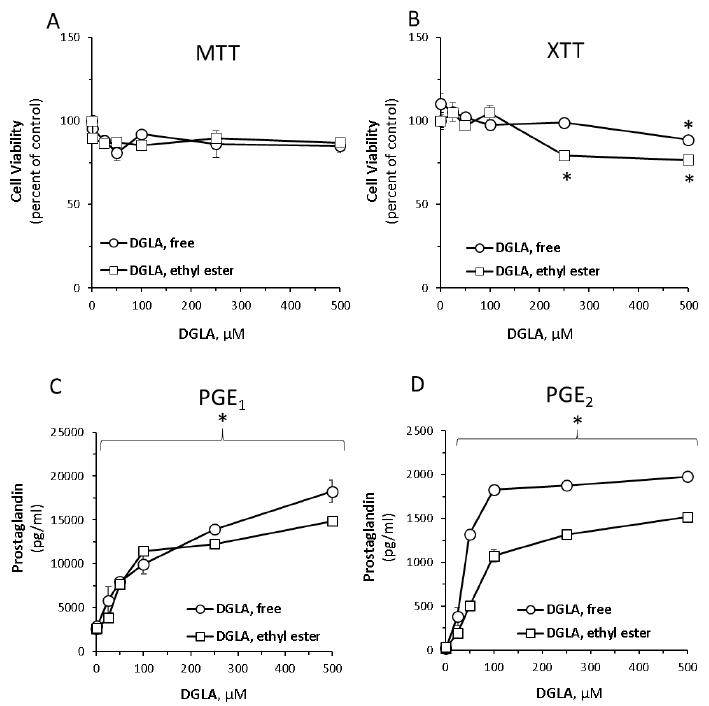
Figure 1. Dose-dependent response evaluation of dihomo- γ -linolenic acid (DGLA) free acid and ethyl ester forms in RAW264.7 macrophages. Cells were treated with increasing concentrations of DGLA in its free or ethyl ester form for 24 h. Cell viability was determined by 3-(4,5- dimethylthiazol-2-yl)-2,5-diphenyltetrazolium bromide (MTT) ( A ) and tetrazolium-formazan (XTT) ( B ) assays, as indicated in the Methods section. Prostaglandin E1 (PGE1) ( C ) and prostaglandin E2 (PGE2) ( D ) were quantified in culture supernatants. Dimethyl sulfoxide (DMSO) at 1:1000 (the final concentration in the cell culture media was 0.1% in all treatment groups) was used as a vehicle control and did not a ff ect the cells viability. Data are presented as mean ± standard deviation (SD). * denotes a significant di ff erence compared to untreated control, p < 0.05, n =